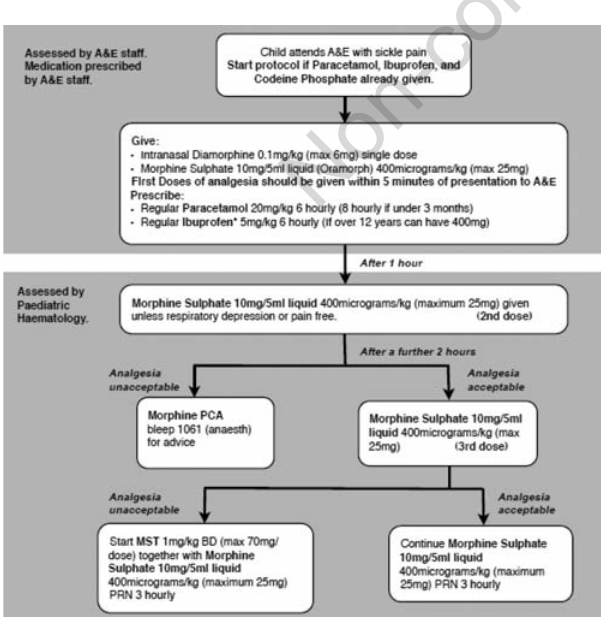
Figure 1. Royal London Hospital paediatric sickle cell pain man- agement